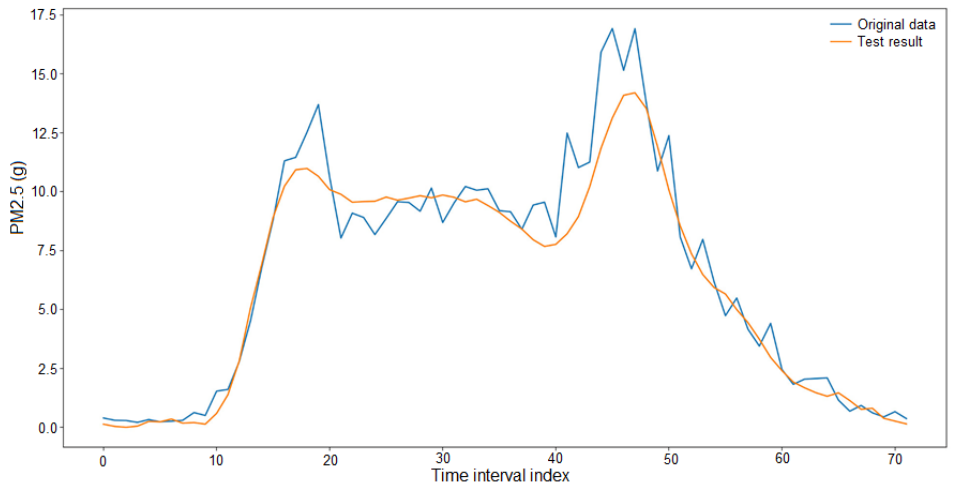
Figure 13. Measured PM2.5 emissions over 24 h and PM2.5 emissions forecasted by the neural network.